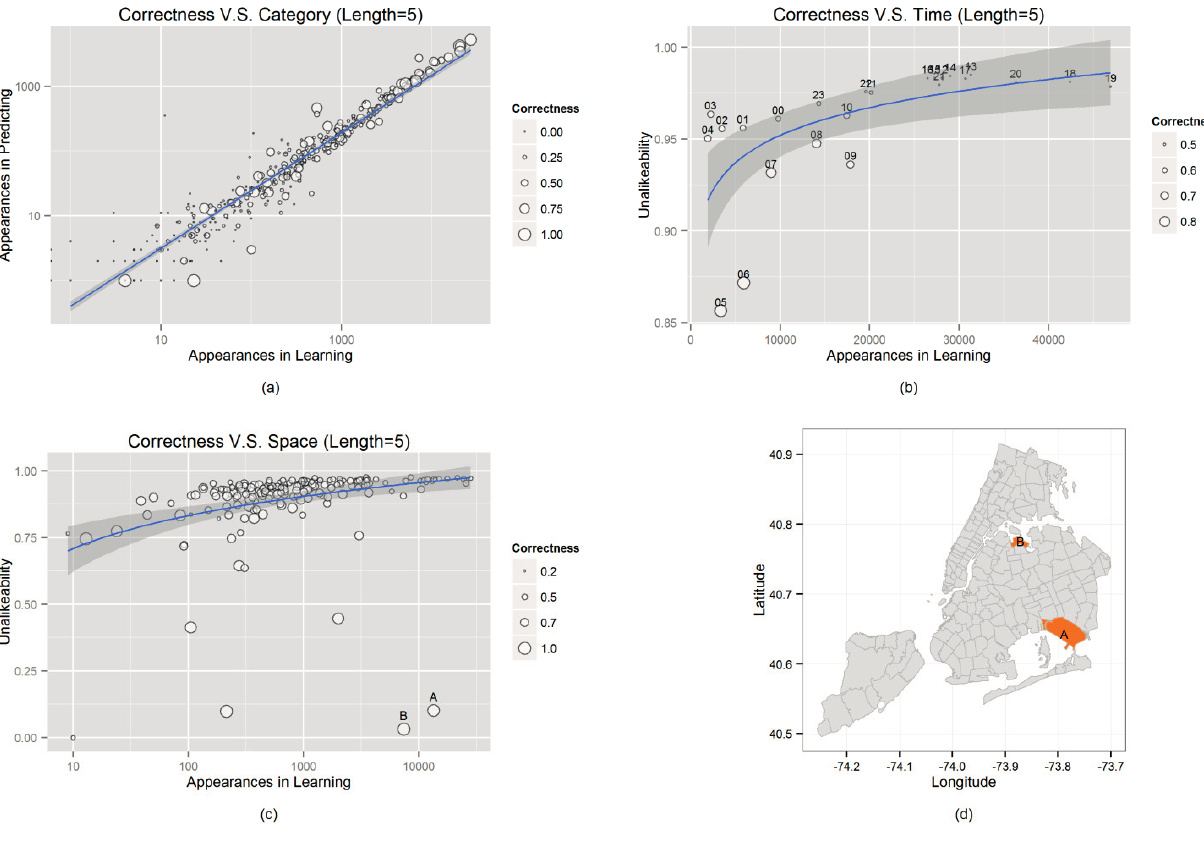
Figure 5. Relations between correctness and check-in category ( a ), time ( b ) and space ( c ) respectively. Subplot ( d ) mapped the two outliers in subplot (c) in the real geographic